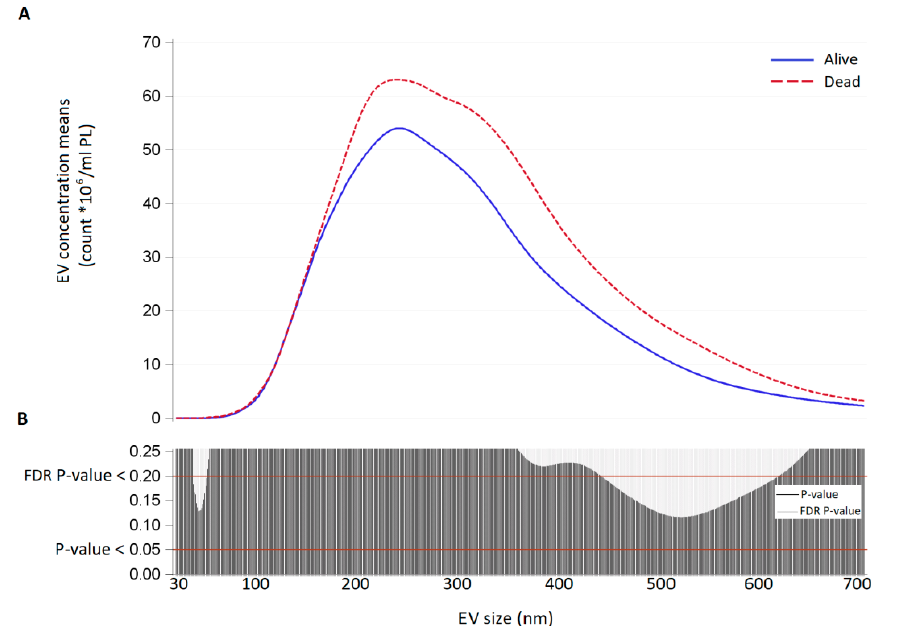
Figure 2. ( A ) EV concentration means (count × 10 6 /mL) for each size (30–700 nm) in amniotic fluid samples of survivors (continuous blue line) and non-survivors (dashed red line), collected at balloon insertion. ( B ) Significance of the difference between survivors and non-survivors for each EV size expressed as p -value and False Discovery Rate P-value from Poisson regression models allowing for over-dispersion.